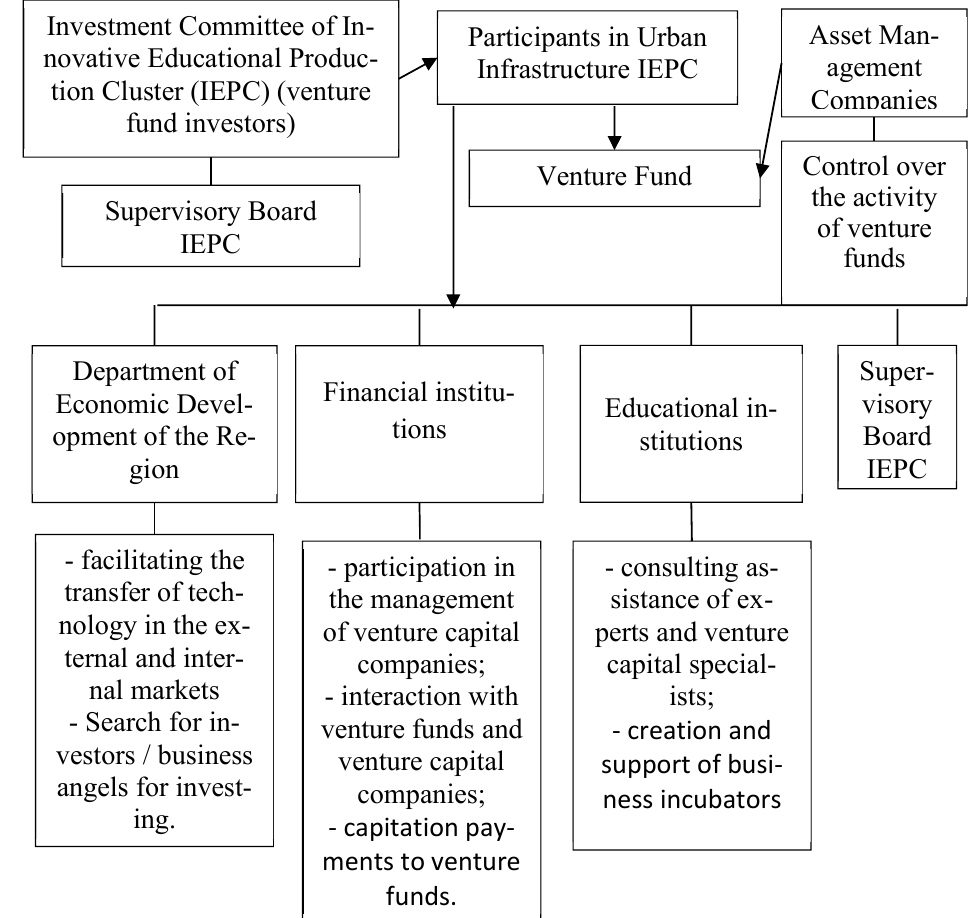
Fig. 4. Innovative educational and production cluster management scheme Table 2 Calculation of indicators of efficiency of functioning of urban infrastructure of innovative educational and production cluster (IEPC)